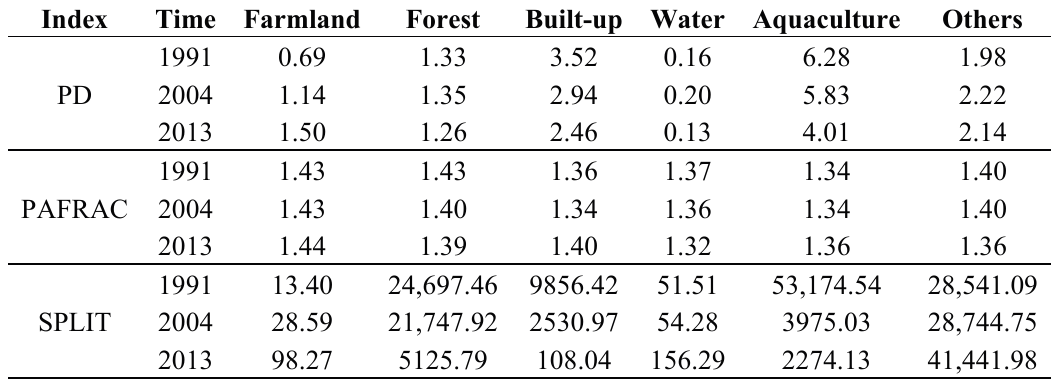
Table A1. Landscape Metrics for Land Cover Types in the Study Region over Time.